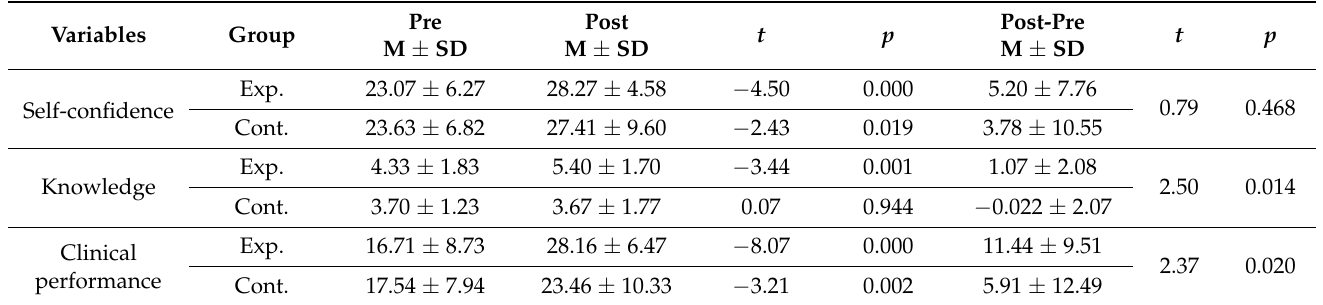
Table 3. Mean score comparisons between experimental group and control group per variable ( n = 91).